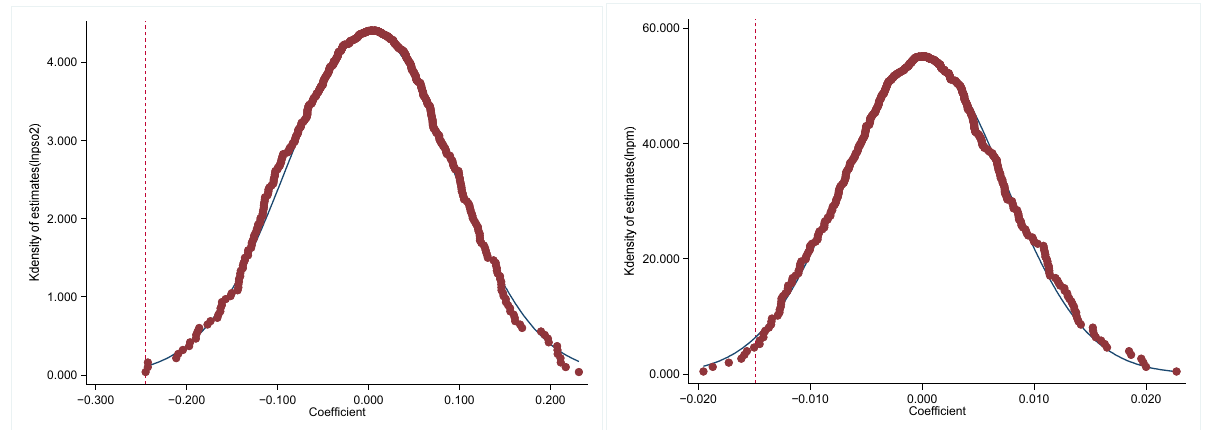
Figure 2. Placebo test.